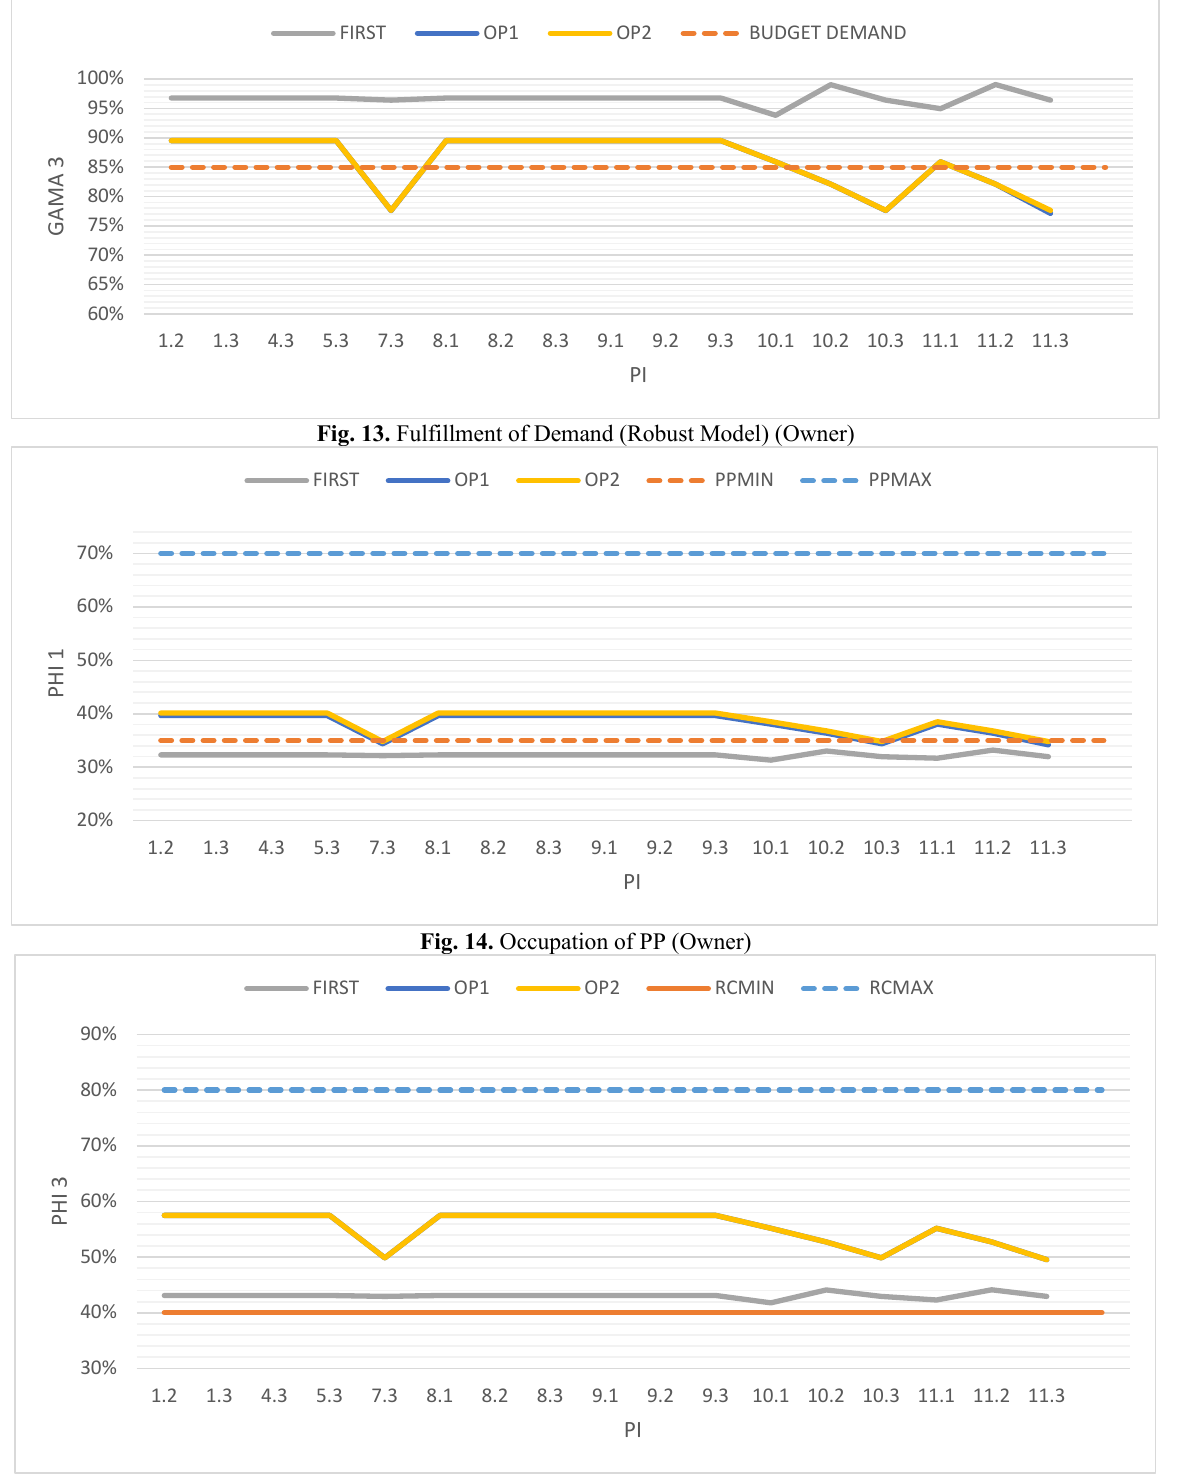
Fig. 15. Occupation of RC